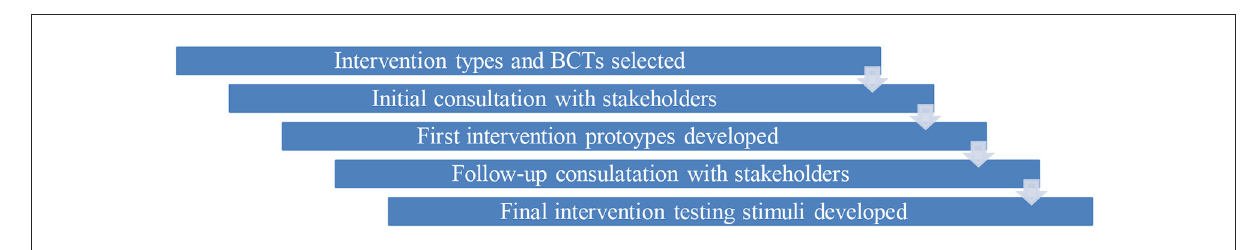
FIGURE5 Overview of materials and resources used as evidence.